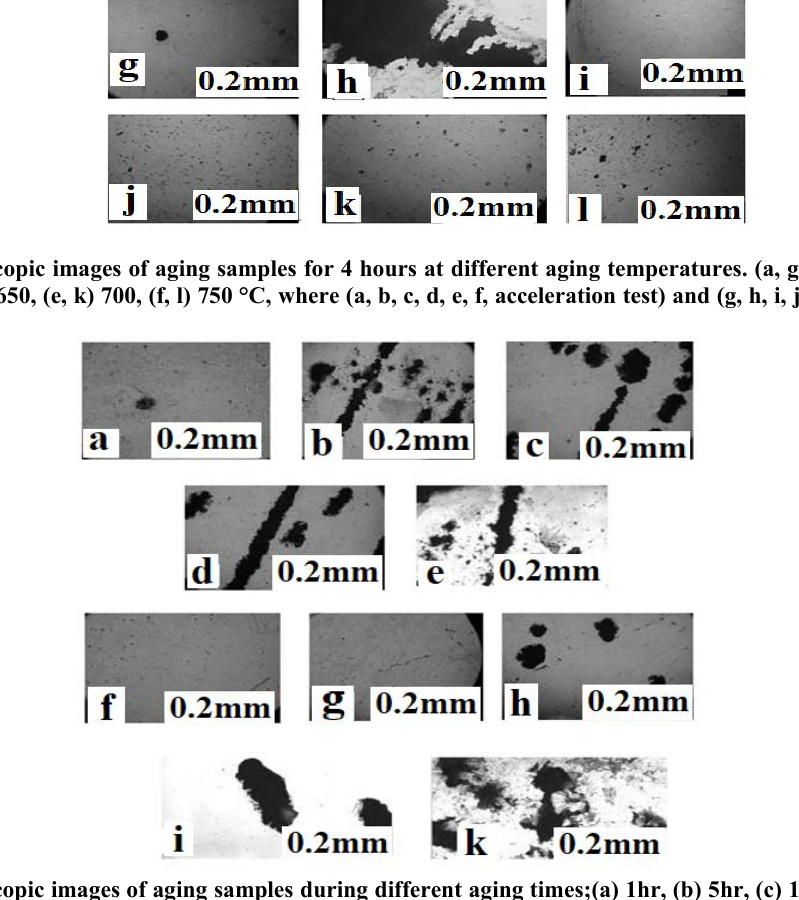
Fig. 18. Microscopic images of aging samples during different aging times;(a) 1hr, (b) 5hr, (c) 10hr, (d) 15hr, (e) 20hr: acceleration test where (a, b, c, d, e) at 500 °C and (f, g, h, i, k) at 650